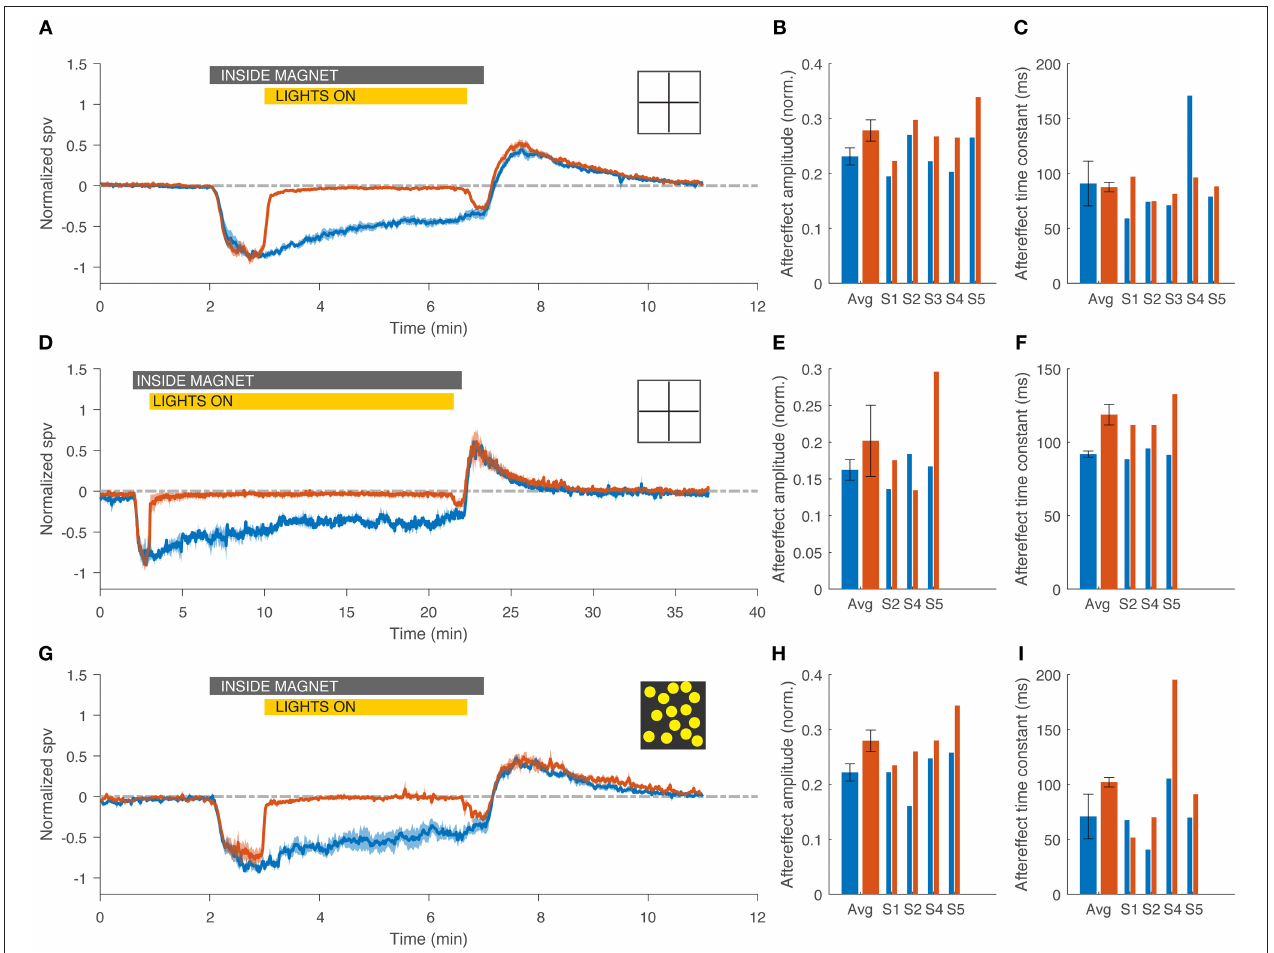
FIGURE 3 | Visual fixation had little impact on the adaptation to the magnetic vestibular stimulus, regardless of the duration of fixation (top and middle rows, 5 and 20min) or the visual fixation stimulus (top and bottom rows, 5min, simple cross and rich full field stimulus). (A,D,G) Average normalized slow-phase velocity (SPV) across subjects for fixation (red) and darkness (blue) conditions. Note the different time scale on the abscissa for the graph in D . (B,E,H) Amplitude of the after effect, calculated for each subject as the area under the curve during the after-effect period (3min after exiting the magnet for the 5min trials and 7min for the 20min trials). (C,F,I) Time constant of the decay of the after effect, calculated with an exponential fit starting at the maximum SPV during the after effect. Gray bar indicates the time the subject was inside the magnet for both trials in darkness and with visual fixation, and yellow bar indicates duration of exposure to visual fixation in the light for trials with fixation only. Bar graphs show average and individual results. Errors bars and shaded area represent standard error of the mean